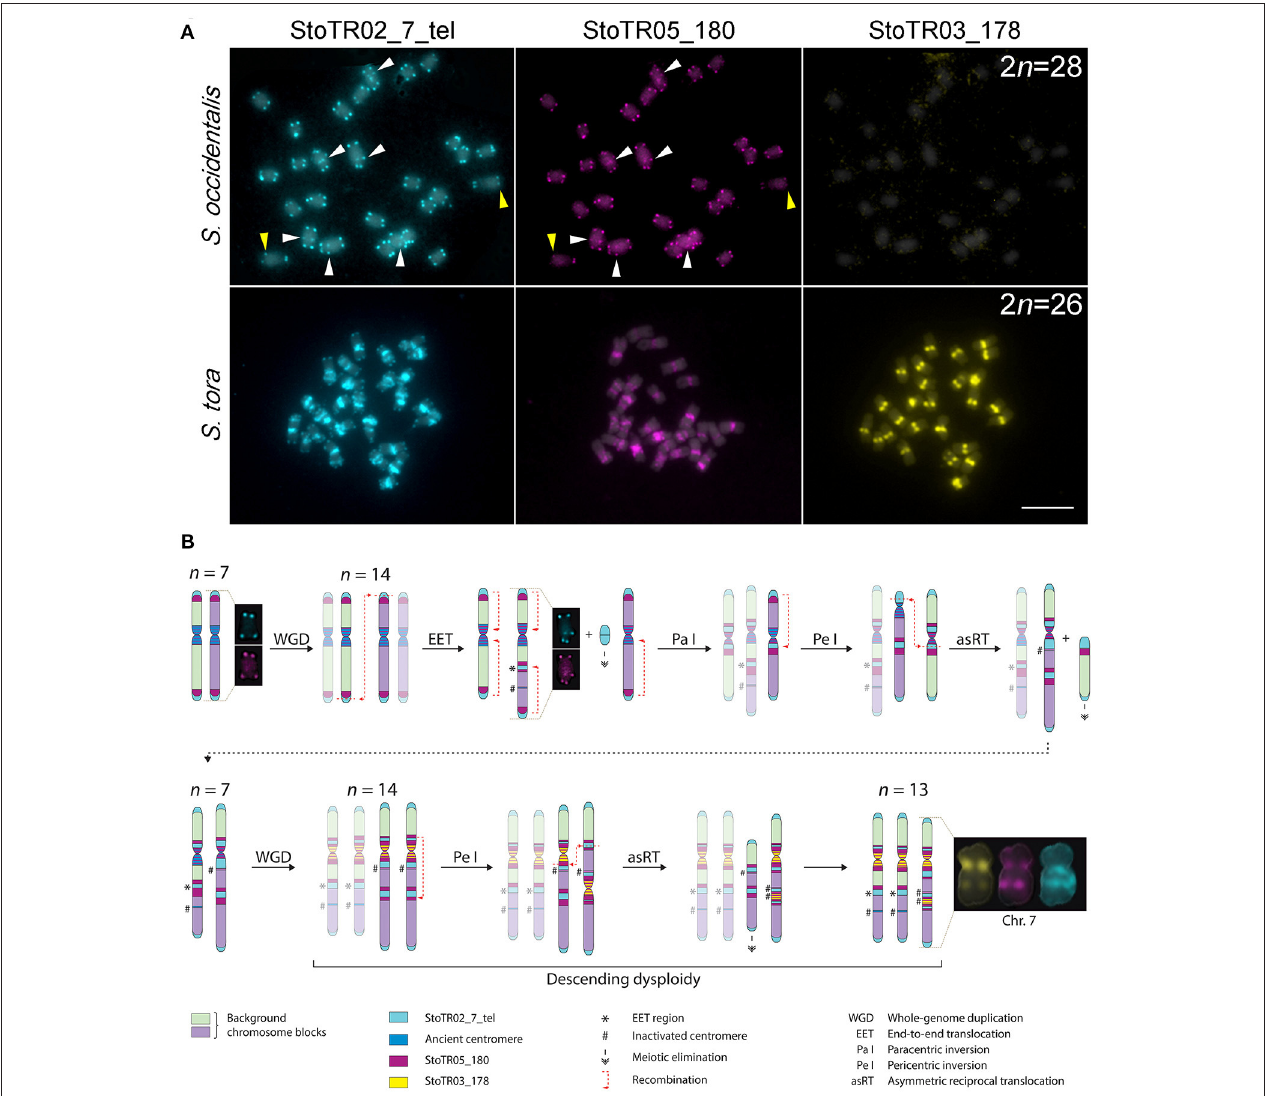
FIGURE 4 | Hypothetical pathway for chromosome dysploidy in S. tora . (A) Comparative FISH of StoTR02_7_tel, StoTR05_180, and StoTR03_178 between S. occidentalis and S. tora . StoTR02_7_tel and StoTR05_180 colocalized at chromosome termini and interstitial regions (white arrowheads) in S. occidentalis with some chromosomes showing differential abundance (yellow arrowheads). Both repeats were localized at pericentric and interstitial regions in S. tora . StoTR03_178 was observed only in S. tora . Bar = 10 µ m. (B) Hypothetical chromosome evolution in S. tora attempts to explain the amplification of and StoTR02_7_tel and StoTR05_180 at pericentromeric and interstitial sites and the emergence of a novel StoTR03_178 centromeric repeat. Dysploidy and non-dysploidy mechanisms revert the chromosome number to n = 7 after a WGD. A second, more recent WGD triggers concerted evolution of StoTR03_178, displacing StoTR05_180 distally from the centromere. Two chromosomes merged forming a derivative chromosome (Chr. 7) causing the extant descending dysploid S. tora karyotype. Chromosomes not involved in a particular process are faded to emphasize chromosome rearrangements